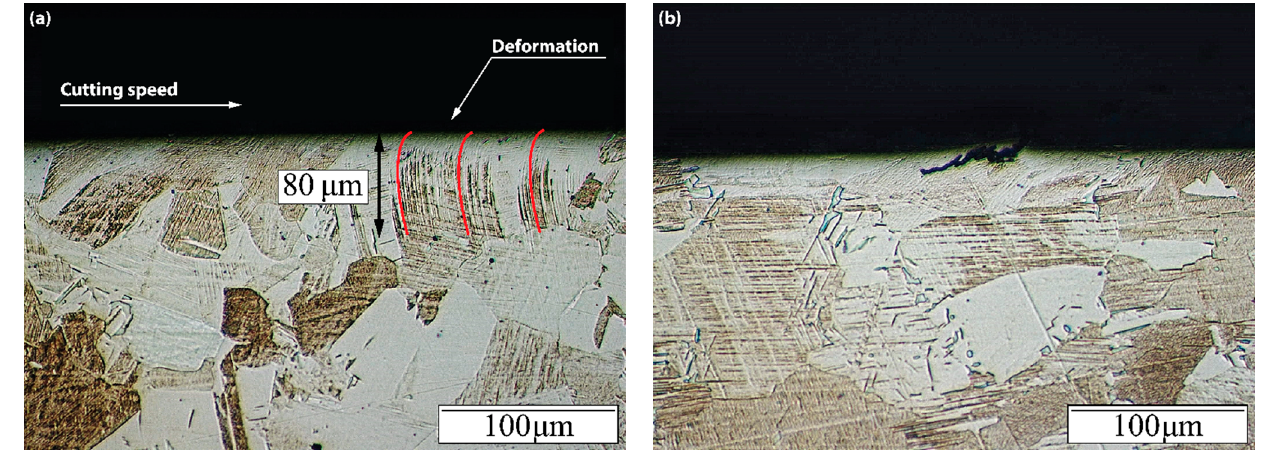
Figure 16. ( a ) Typical microstructure alterations and deformed layer induced by machining (configuration 1 and 50 m/min cutting speed); ( b ) detail of surface cracks (configuration 2 for a cutting speed of 50 m/min).